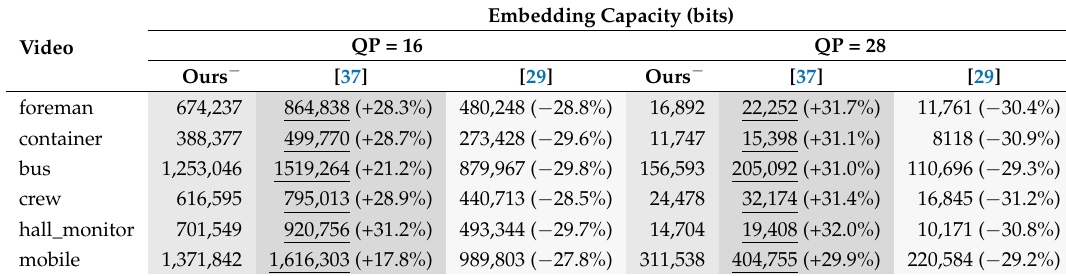
Table 3. The embedding capacity of the schemes without using the ( 0,0 ) coefficient pairs, where the percentage figures in parentheses indicate the relative difference between other schemes and Ours − .